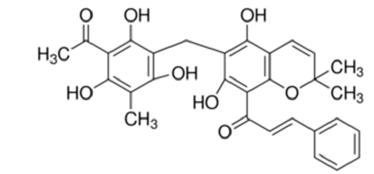
Figure 1. Chemical structure of rottlerin.